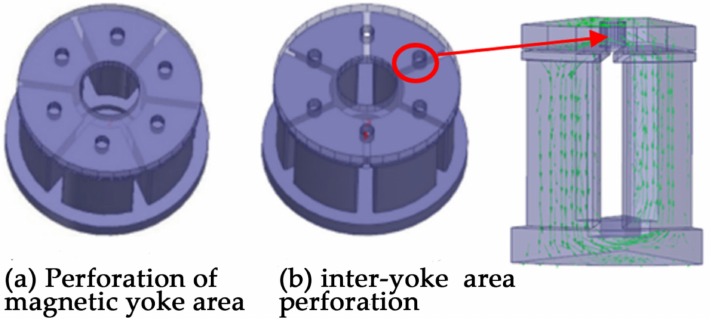
Figure 14. Punching